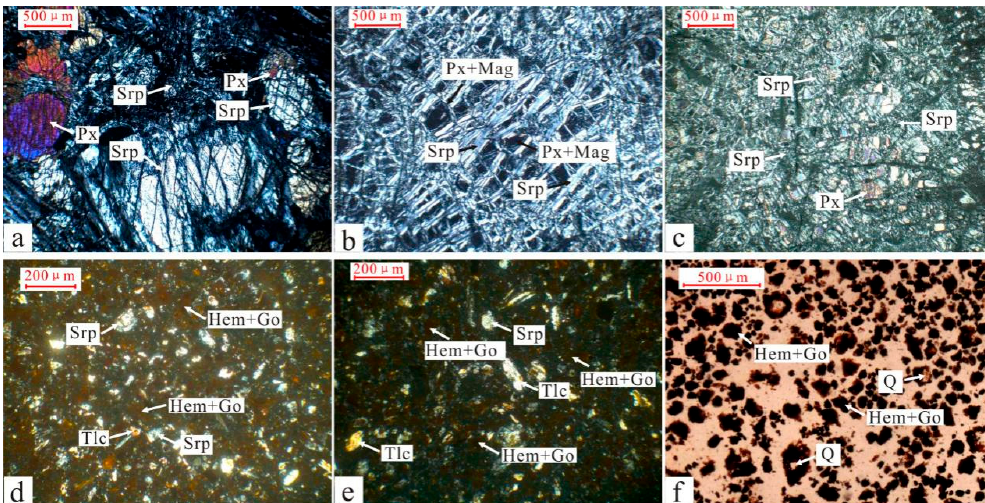
Figure 5 . Microphotographs of the studied samples at the Yuanjiang lateritic Ni profile, showing its mineralogical composition and textures: ( a ) the dominant primary minerals in the bedrock including serpentine and pyroxene; ( b ) a typical mesh structure forming by serpentine, pyroxene and magnetite; ( c ) a small amount of residual pyroxene in the serpentine dominant saprolite horizon; ( d ) hematite and goethite appear in the brown saprolite dominated by serpentine; ( e ) hematite and goethite occur largely coexisting with a small amount of residual talc and serpentine together in the limonite horizon; and ( f ) concretions of hematite and goethite and quartz grains in the uppermost of the limonite horizon. Abbreviations: Go, goethite; Hem, hematite; Srp, serpentine; Qv, quartz; Px, pyroxene; Tlc, talc; Mag, magnetite.